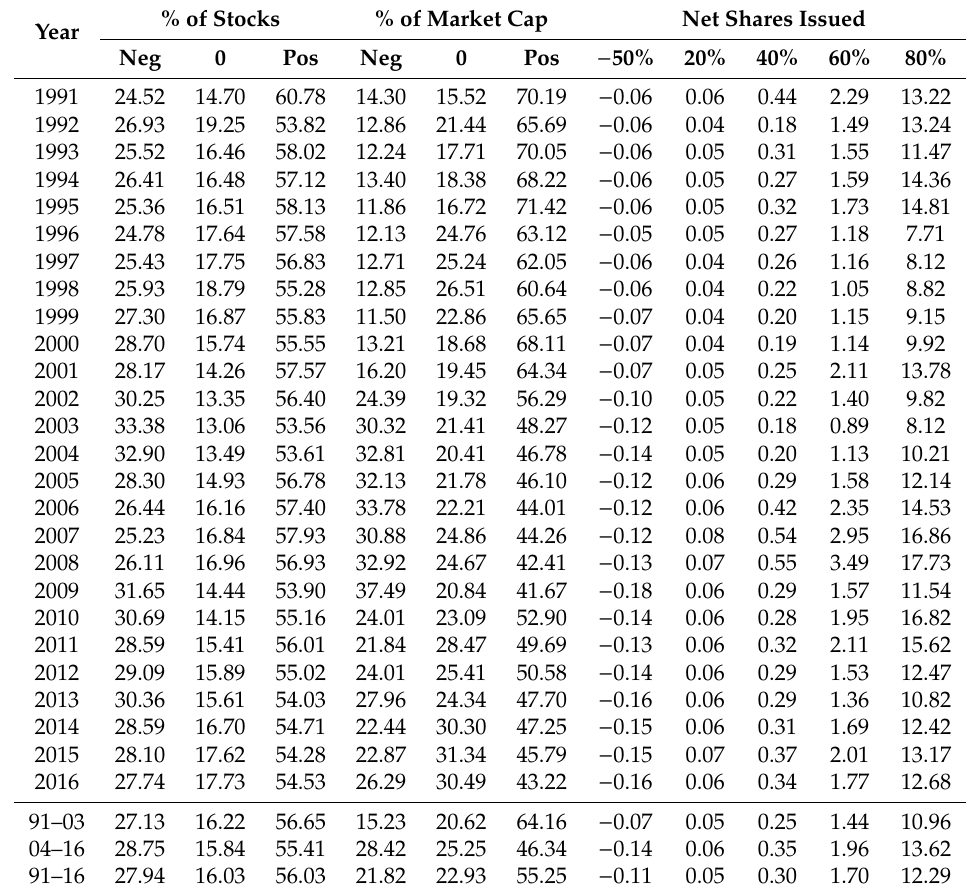
Table 10. Net Shares Issues—Europe 1991–2016. For Europe, net share issues (the number of shares issued minus repurchased) are computed for all stocks on an annual basis. Columns 2–4, % of Stocks, list the fraction of all stocks that are net repurchasers (Neg), net issuers (Pos) and that have zero net issues (0). Columns 5–7, % of Market Cap, list the percent of total market capitalization of net repurchasers, net issuers, and firms that don not repurchase or issue. The last five columns list the median percent share repurchase ( − 50%), as well as the quintile breakpoints for issues. The last three rows provide averages over the full sample, ‘91–16’, and over two subperiods, ‘91–03’ and